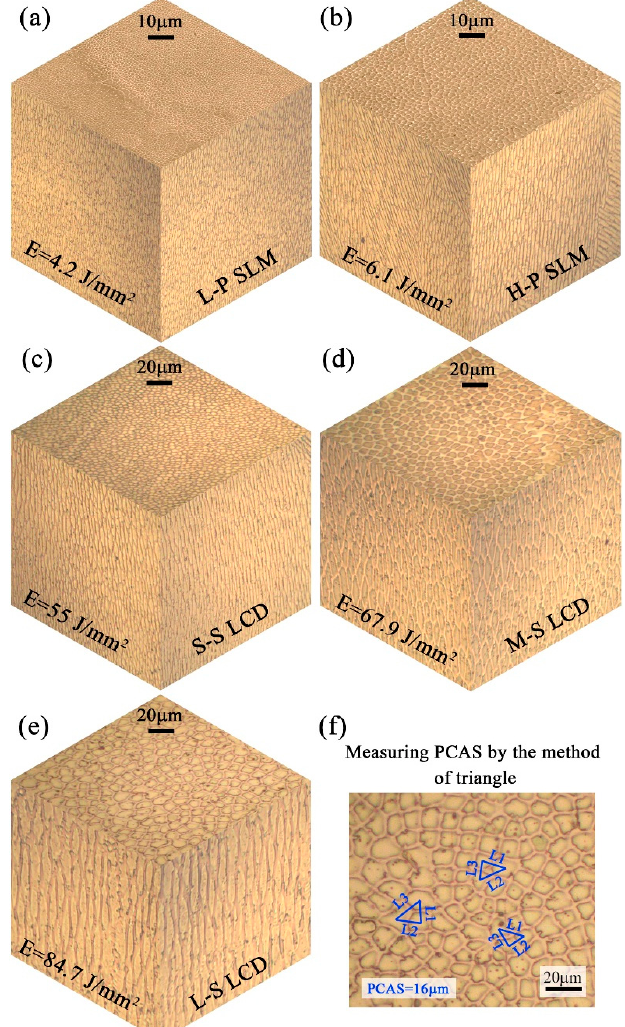
Figure 7. 3D composite view showing the cellular morphologies of the five kinds of typical samples at the processing parameters of ( a ) low-power laser powder bed fusion (LPBF), ( b ) high-power LPBF, ( c ) small-size DED, ( d ) middle-size DED, and ( e ) large-size DED. ( f ) Schematic sketch of measuring PCAS by the three-angle method [49].